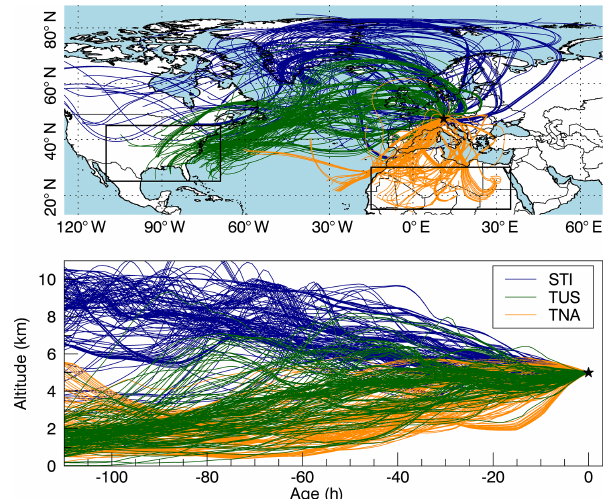
Figure 6. Categorization of backward trajectories for long-range- transport events: map projection (upper panel) and vertical cross section (lower panel) for stratospheric intrusions, transport from North America, and transport from northern Africa. Black boxes in- dicate source regions used to classify TUS and TNA (see Table 2), and the black star marks